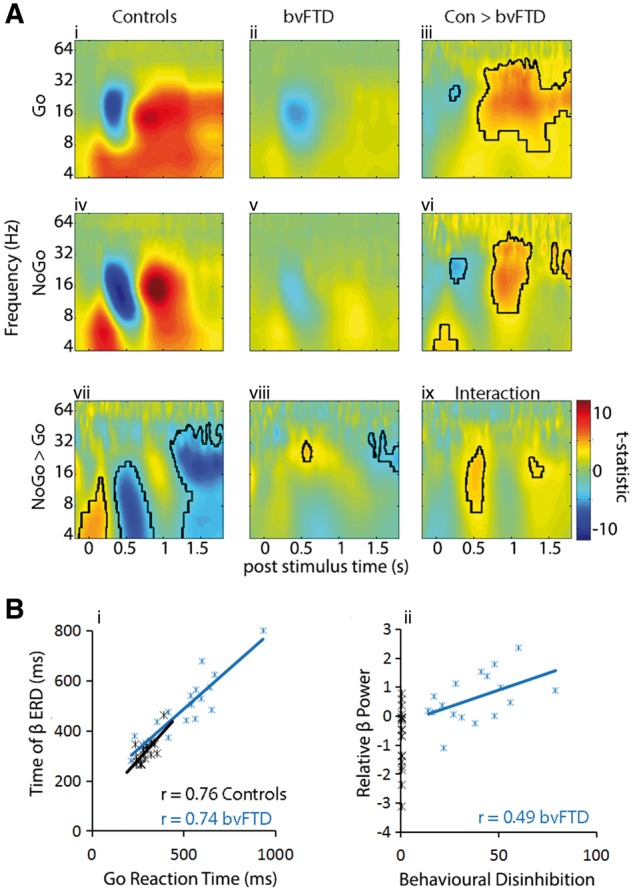

Time frequency spectra and relationship with behaviour. (A) Time frequency spectra for controls and bvFTD patients for successful Go and NoGo trials. A clear ERD/ERS in the beta/alpha bands and an early increase in theta are evident, which are diminished in patients. Contrasts between conditions (vi–vii) and between groups (iii, vi) are plotted with significant statistical thresholds outlined in black (F tests, P < 0.05 clusterwise corrected after P < 0.001 voxelwise threshold). The interaction (Go versus NoGo × Patients versus Controls, ix) reveals two windows of significance, used for further analyses. [B(i)] Time of peak beta desynchronization plotted against reaction times, revealing a tight link between desynchronization and movement. [B(ii)] Plot of relative beta power (the difference between Go and NoGo trials), at the peak of the significant interaction (18 Hz at 540 ms), which correlates with behavioural measures of disinhibition from the CBI. The correlation is positive, indicating that patients who are more behaviourally disinhibited have less desynchronization during successful NoGo trials.